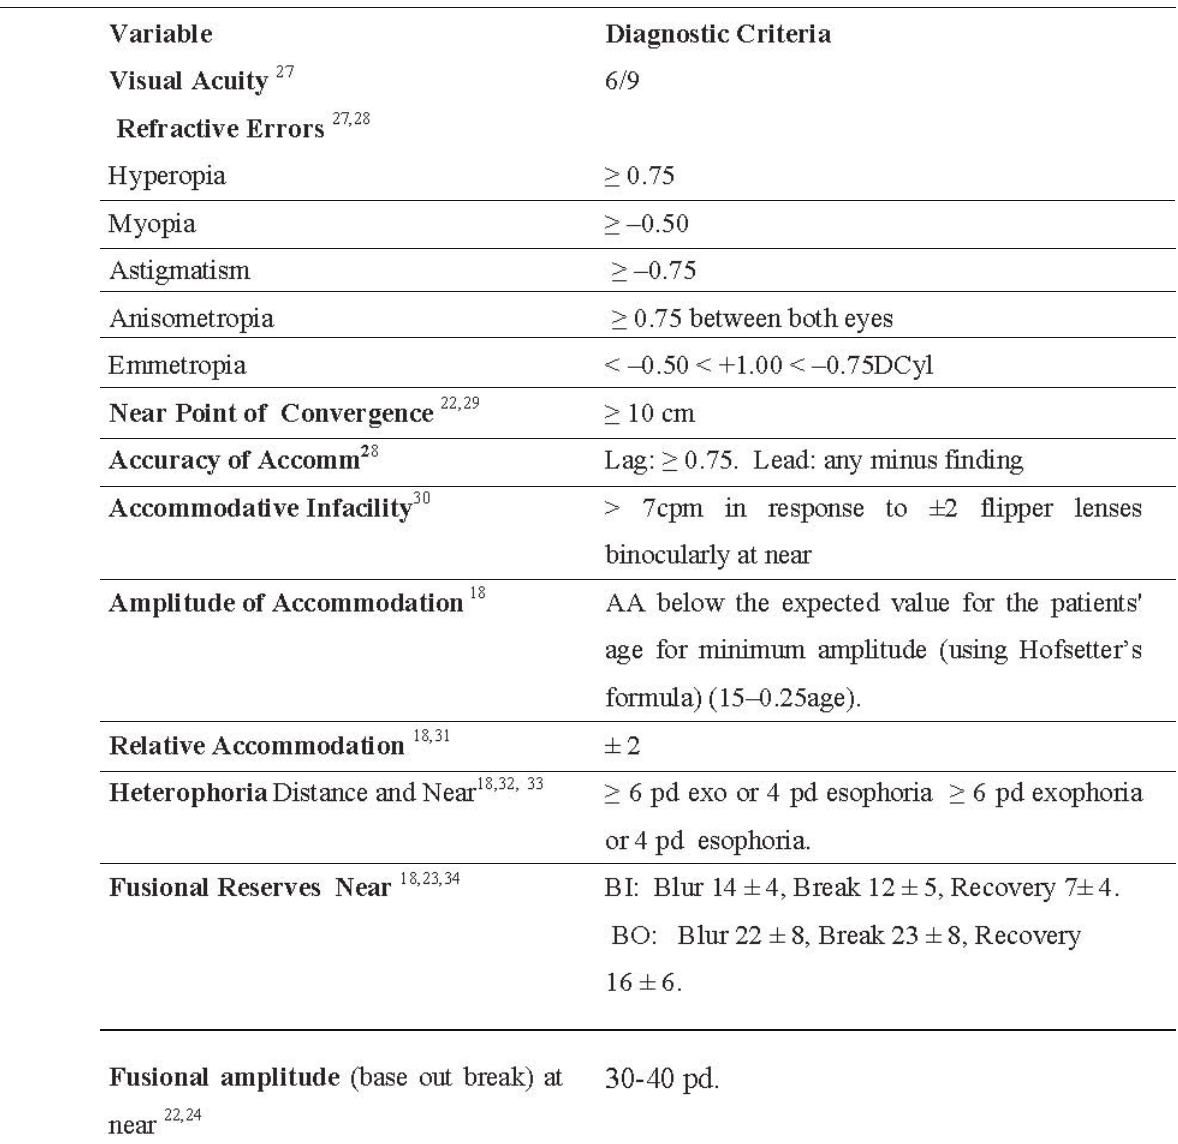
Table 1 . The diagnostic criteria for each test